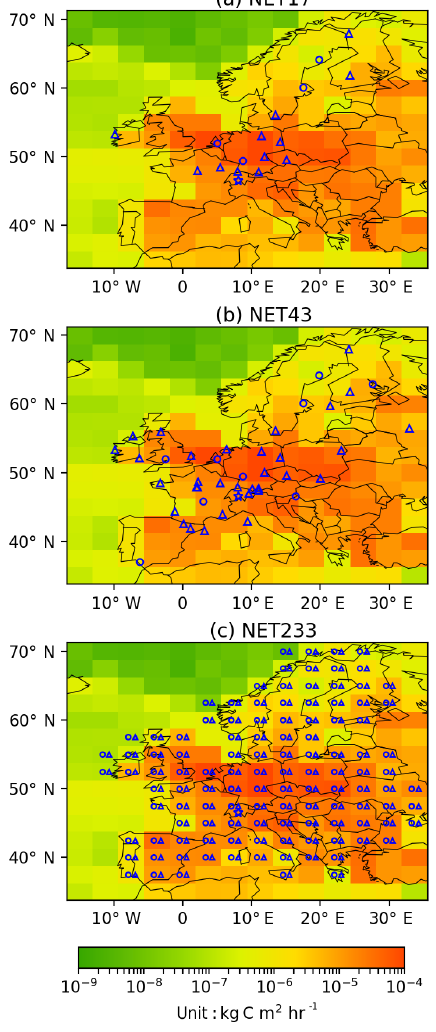
Figure 1. Site locations for the three continental network configu- rations used in this study: (a) NET17, (b) NET38 and (c) NET232. Circles correspond to “urban” sites and upper triangles are “rural” sites. Urban and rural sites are categorized according to the popu- lation density of the grid cells within which the stations are located and according to the locations of large point sources. The back- ground color map is the annual FFCO 2 emissions in 2007 at the resolution of LMDZv4 from the PKU-CO 2 inventory (Wang et al.,